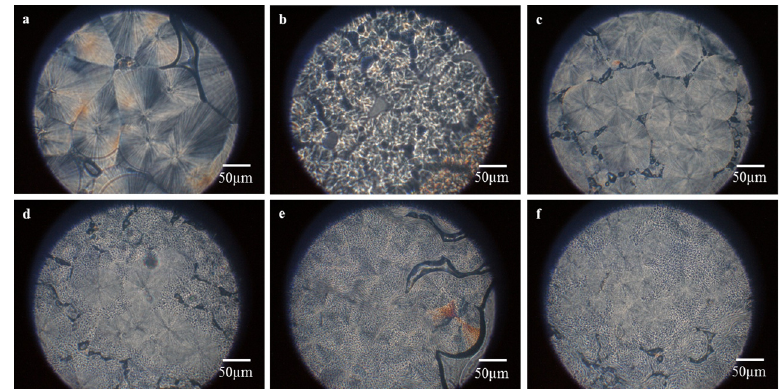
Figure 5. Polarized light microscopy (PLM) images of ( a ) pure PP film; ( b ) HDPE film, and PP/HDPE polyblends, which contain ( c ) 5 wt %; ( d ) 10 wt %; ( e ) 15 wt %, and ( f ) 20 wt % of HDPE.